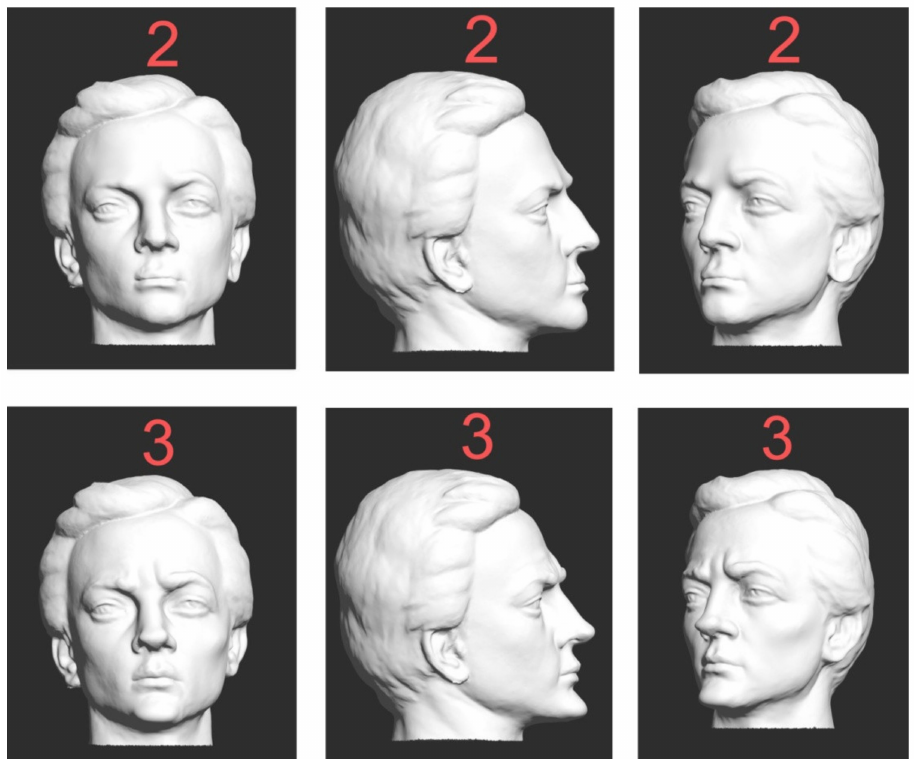
Figure 14. Sculptures 2 and 3 in three characteristic views (frontal, profile, and semi-profile) with geometric modifications added in the Zbrush